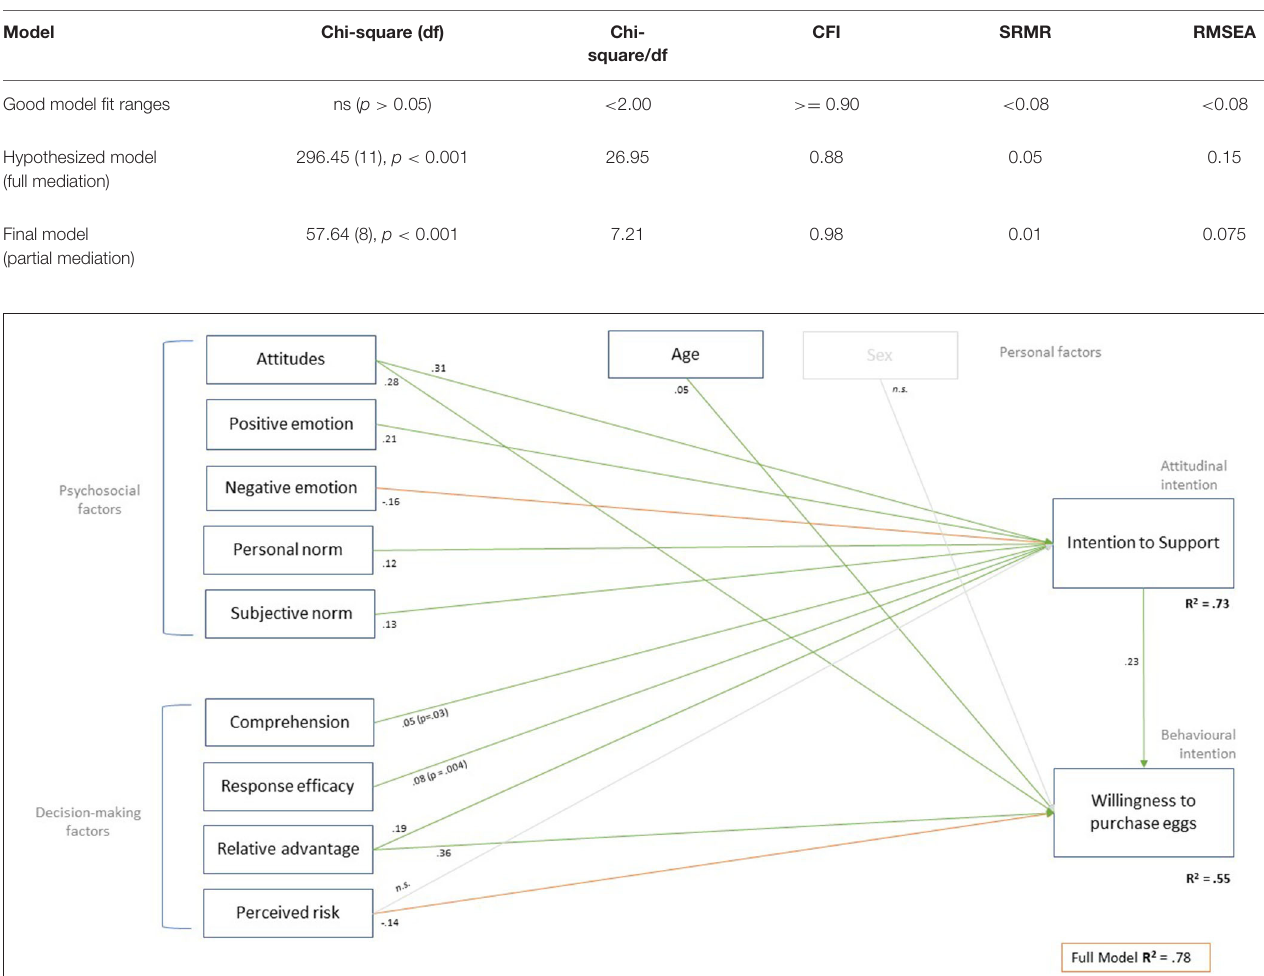
TABLE 3 | Fit statistics for the hypothesized and final path models.